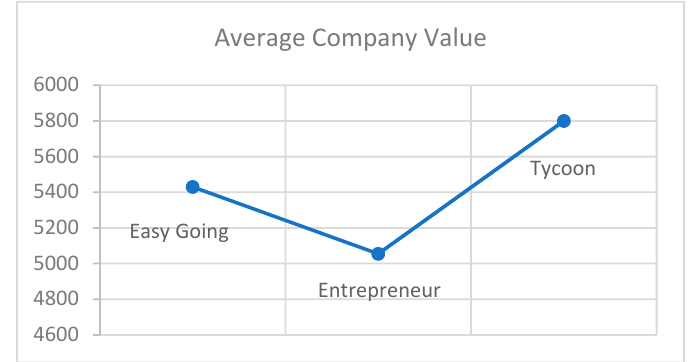
Figure 3. Average company values of the three difficulty levels.